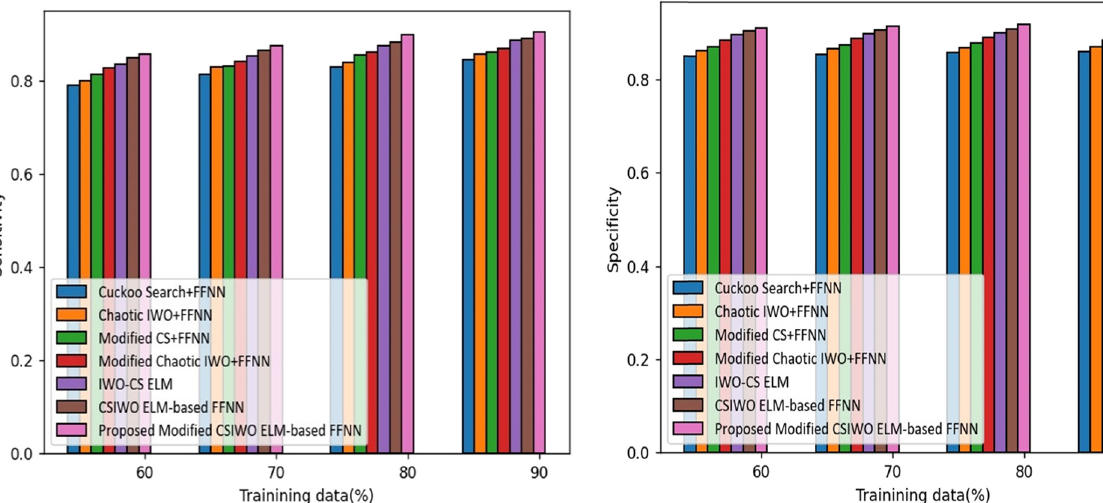
Figure 8: Analysis based on optimization value function - based sensitivity.